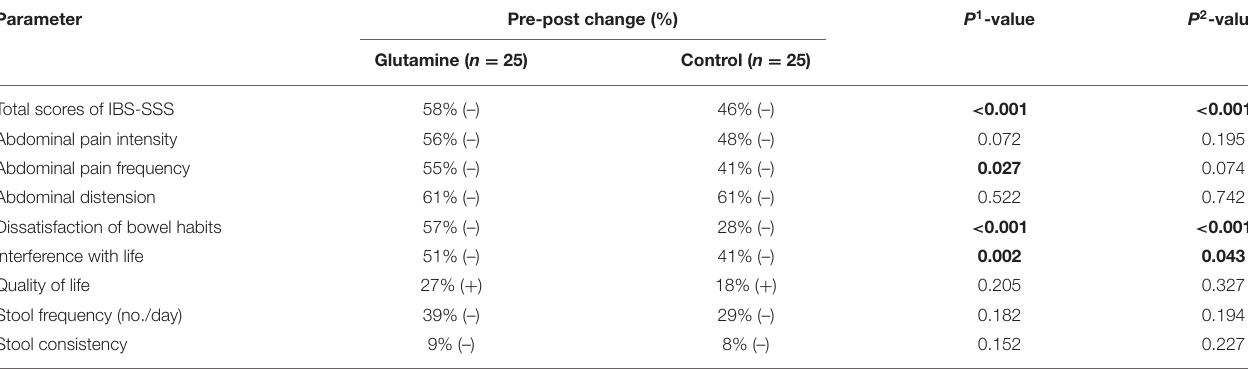
TABLE 4 | Effects of intervention on studied